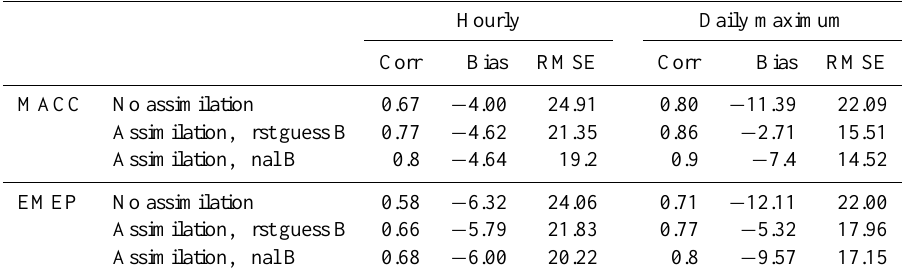
Table 3. Comparison of performance indicators for ozone in the 2012 reanalysis. The scores are given for station sets “MACC” and “EMEP” as defined in Sect. 2.2. For the analysis runs, scores are shown for the different background error covariance matrices discussed in Sect. 3. The unit of bias and RMSE is µgm − 3 .